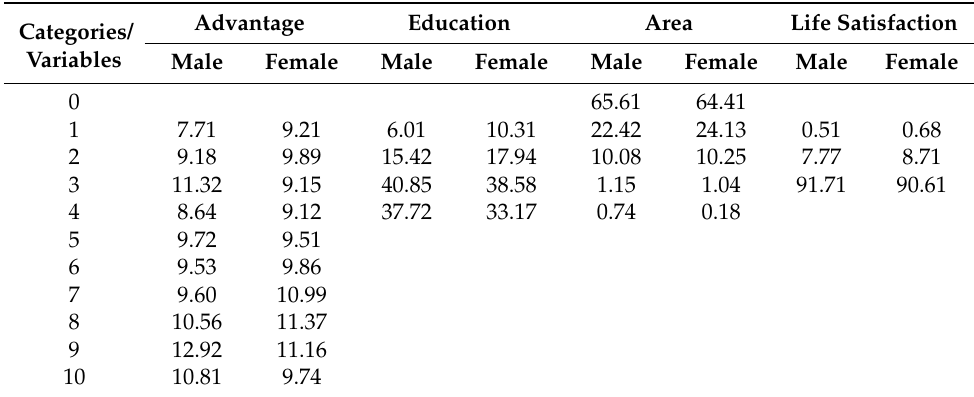
Table 3. The Frequency Distribution of Categorical Variables